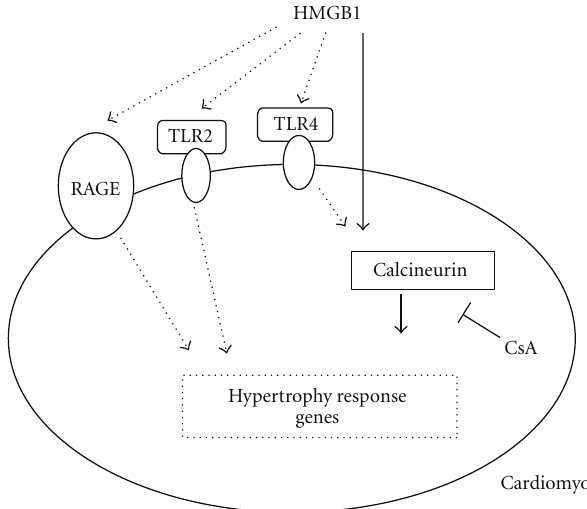
Figure 6: Proposed model for HMGB1 regulation of hypertrophy in NRVMs. HMGB1 induces hypertrophy associated with the activation of calcineurin, and this e ff ect can be partially inhibited by CsA pretreatment. The solid arrows show the confirmative e ff ect determined in this study, while the dashed arrows show the possible pathways to be determined. CsA: cyclosporin A; TLR2: Toll-like receptor-2; TLR4: Toll-like receptor-4; RAGE: receptor for advanced glycation end